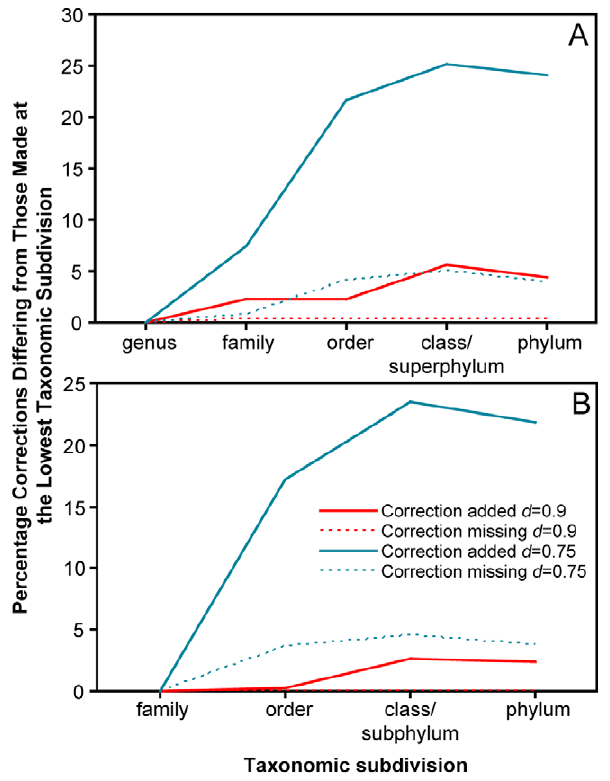
Figure 3. Stability of ORFcor corrections with increasing taxonomic divergence of the dataset. Values shown indicate ORFcor corrections that differ between test datasets subdivided at the lowest (genus in A; family in B) and higher taxonomic subdivisions. Genomes not classified at particular taxonomic levels were excluded from